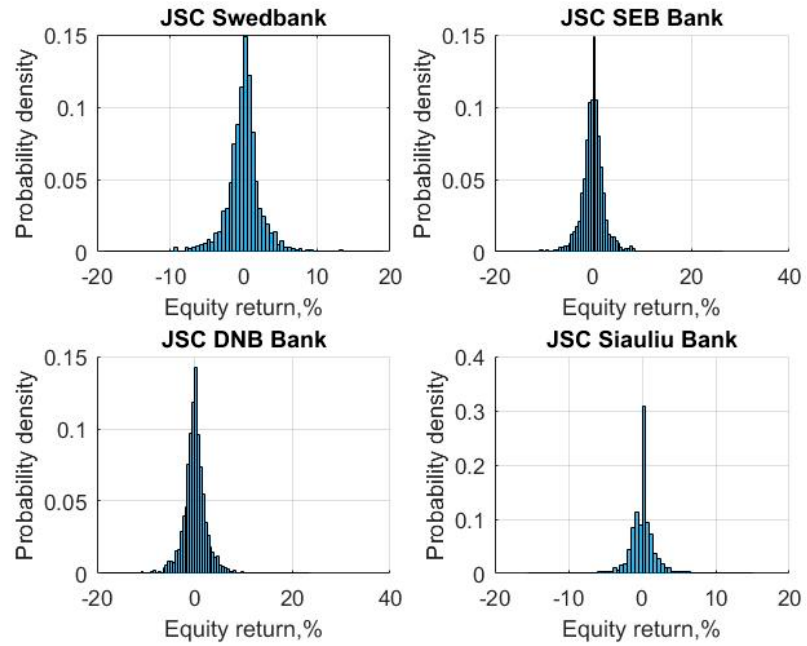
Figure 1. Stock return histograms of Lithuanian banks for the years 2008–2016.